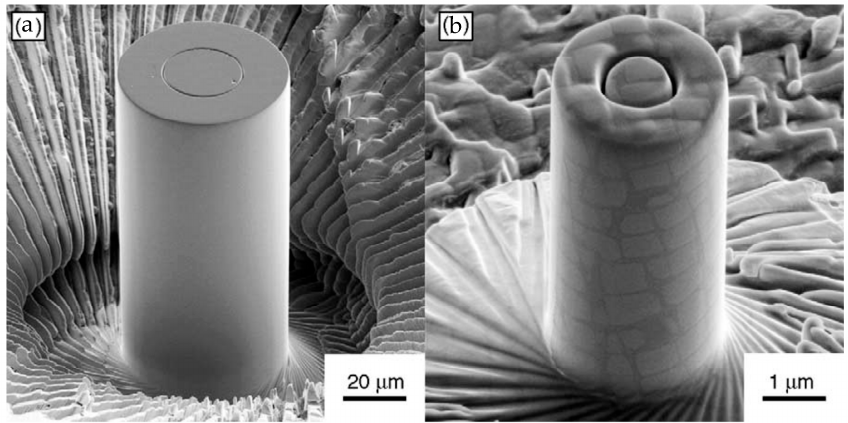
Figure 1. The images of Ni super alloy pillars prepared by focused - ion - beam milling: ( a ) A Ni3(Al, Hf) single crystal pillar with the diameter of 43 μ m; ( b ) a single-crystal Ni super alloy (UM-F19) pillar with the diameter of 2.3 μ m (after Uchic et al. [7]).